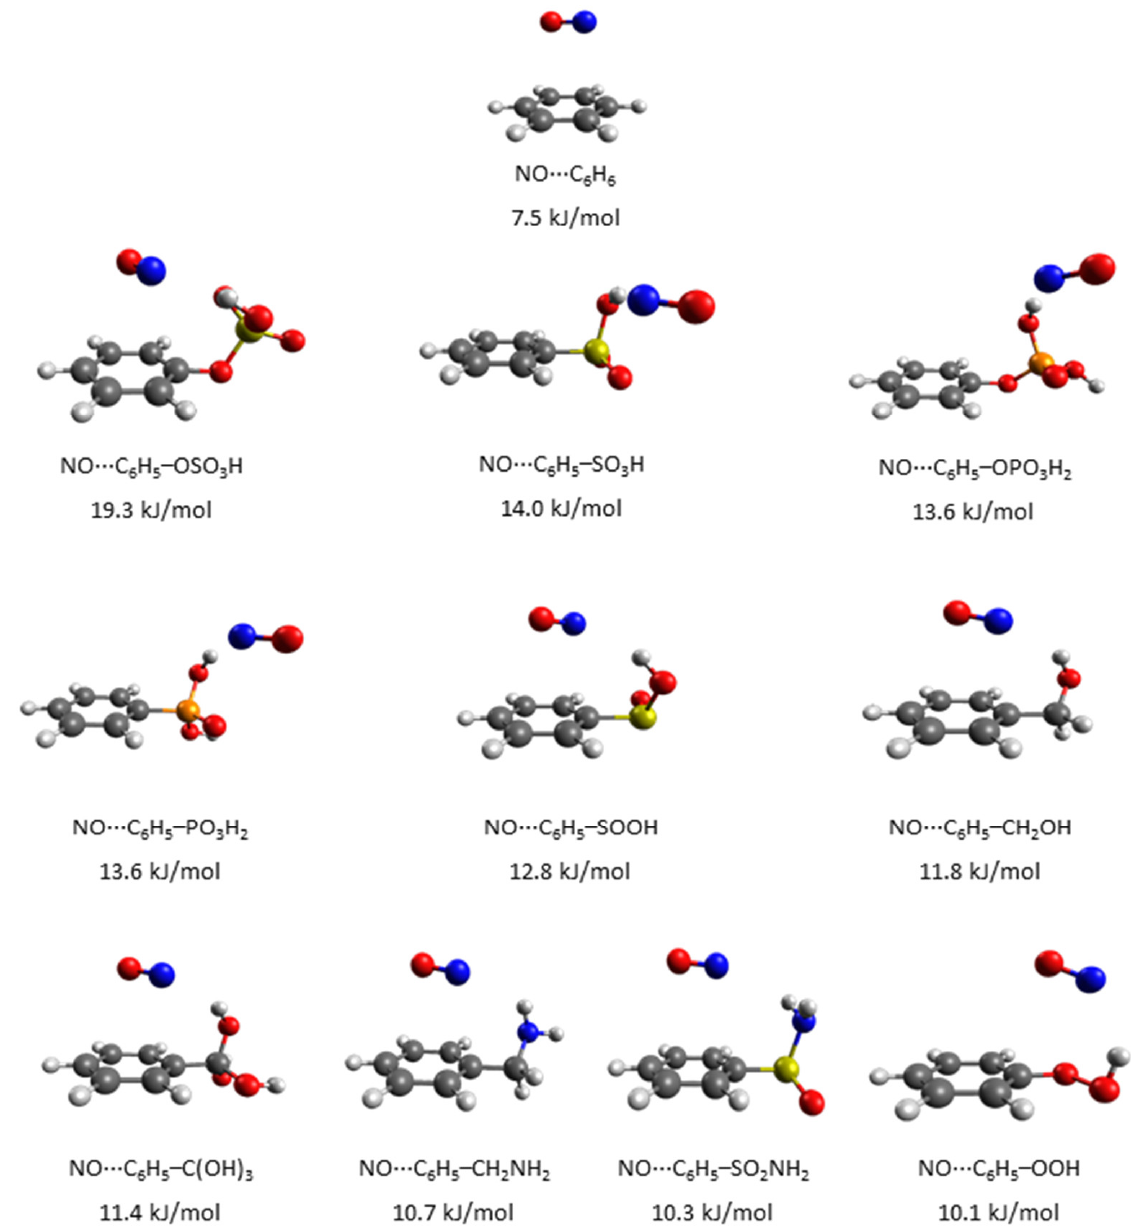
Figure 3. RI-DSD-BLYP/def2-TZVPP optimized geometries for the 10 most energetically favorable dimers.